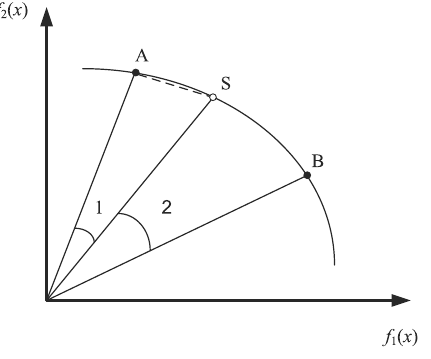
Fig. 6 Leader solution competitive selection mechanism for elite solution